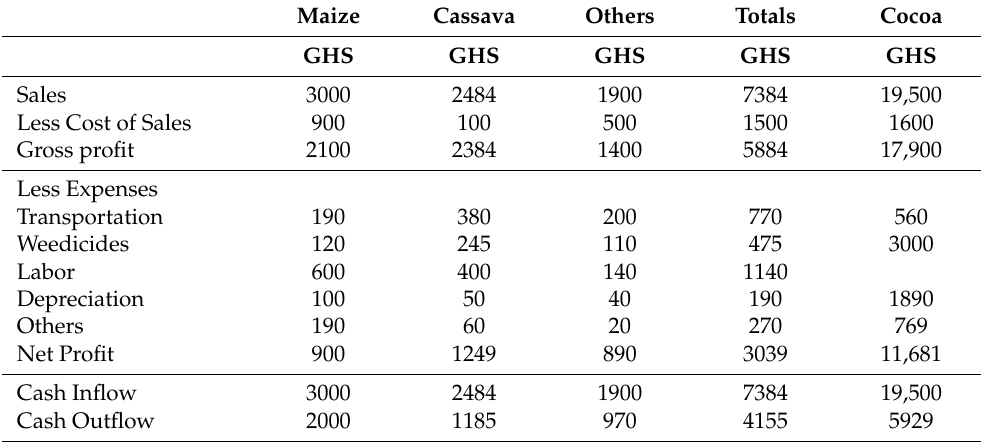
Table A3. Profit and loss of various staple and cash crops in the Ashanti region of